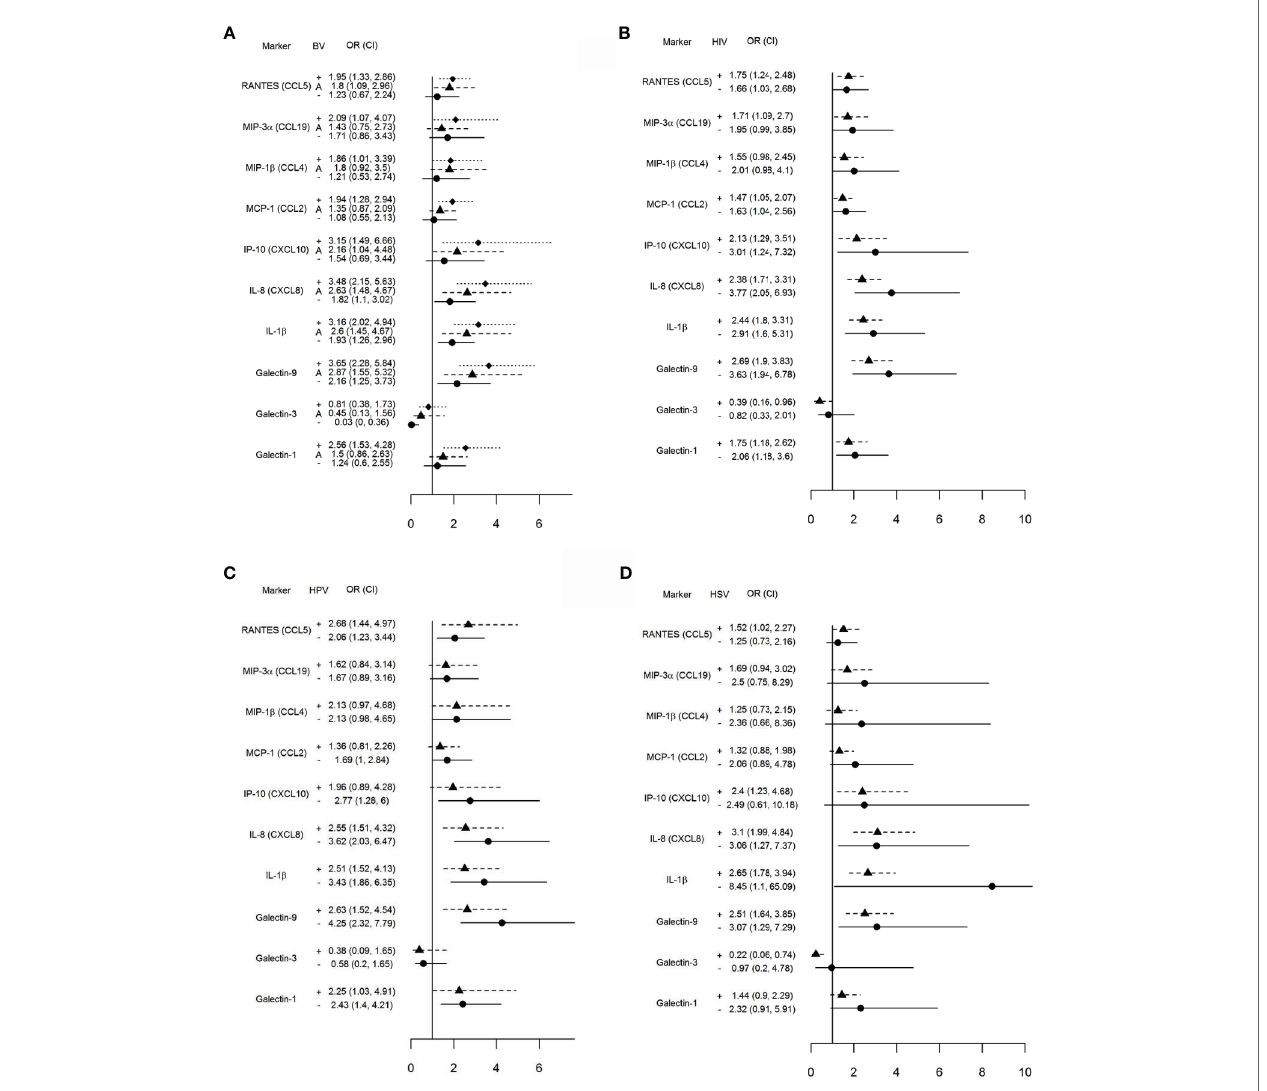
FIGURE 1 | Impact of vaginal microbiota disturbance (A) , HIV (B) , HPV (C) and genital herpes (D) on odds ratios (OR) and 95% con fi dence intervals (CI) for incident TV with each one log 10 unit increase in immune mediator levels calculated for all 446 visits strati fi ed by: (A) BV[+]: Nugent score = 7 – 10 (square symbol, dotted line), BV[ – ]: Nugent score 0 – 3 (circle symbol, solid line), and A[+] (triangle symbol, dashed line): altered microbiota, Nugent score = 4 – 6; (B) HIV[+] (triangle, dashed line) and [ – ] status (circle, solid line); (C) HPV [+] (triangle, dashed line) or [ – ] status (circle, solid line), and (D) HSV [+] (triangle, dashed line) and [ – ] (circle, solid line) status. The vertical line is set at 1.0, representing an OR of 1. Any 95% CI >1 or <1 indicates signi fi cant positive or respectively negative assocaition between immune mediator levels and TV positive status within each stratum (+, A, or – in A and + or – in B – D